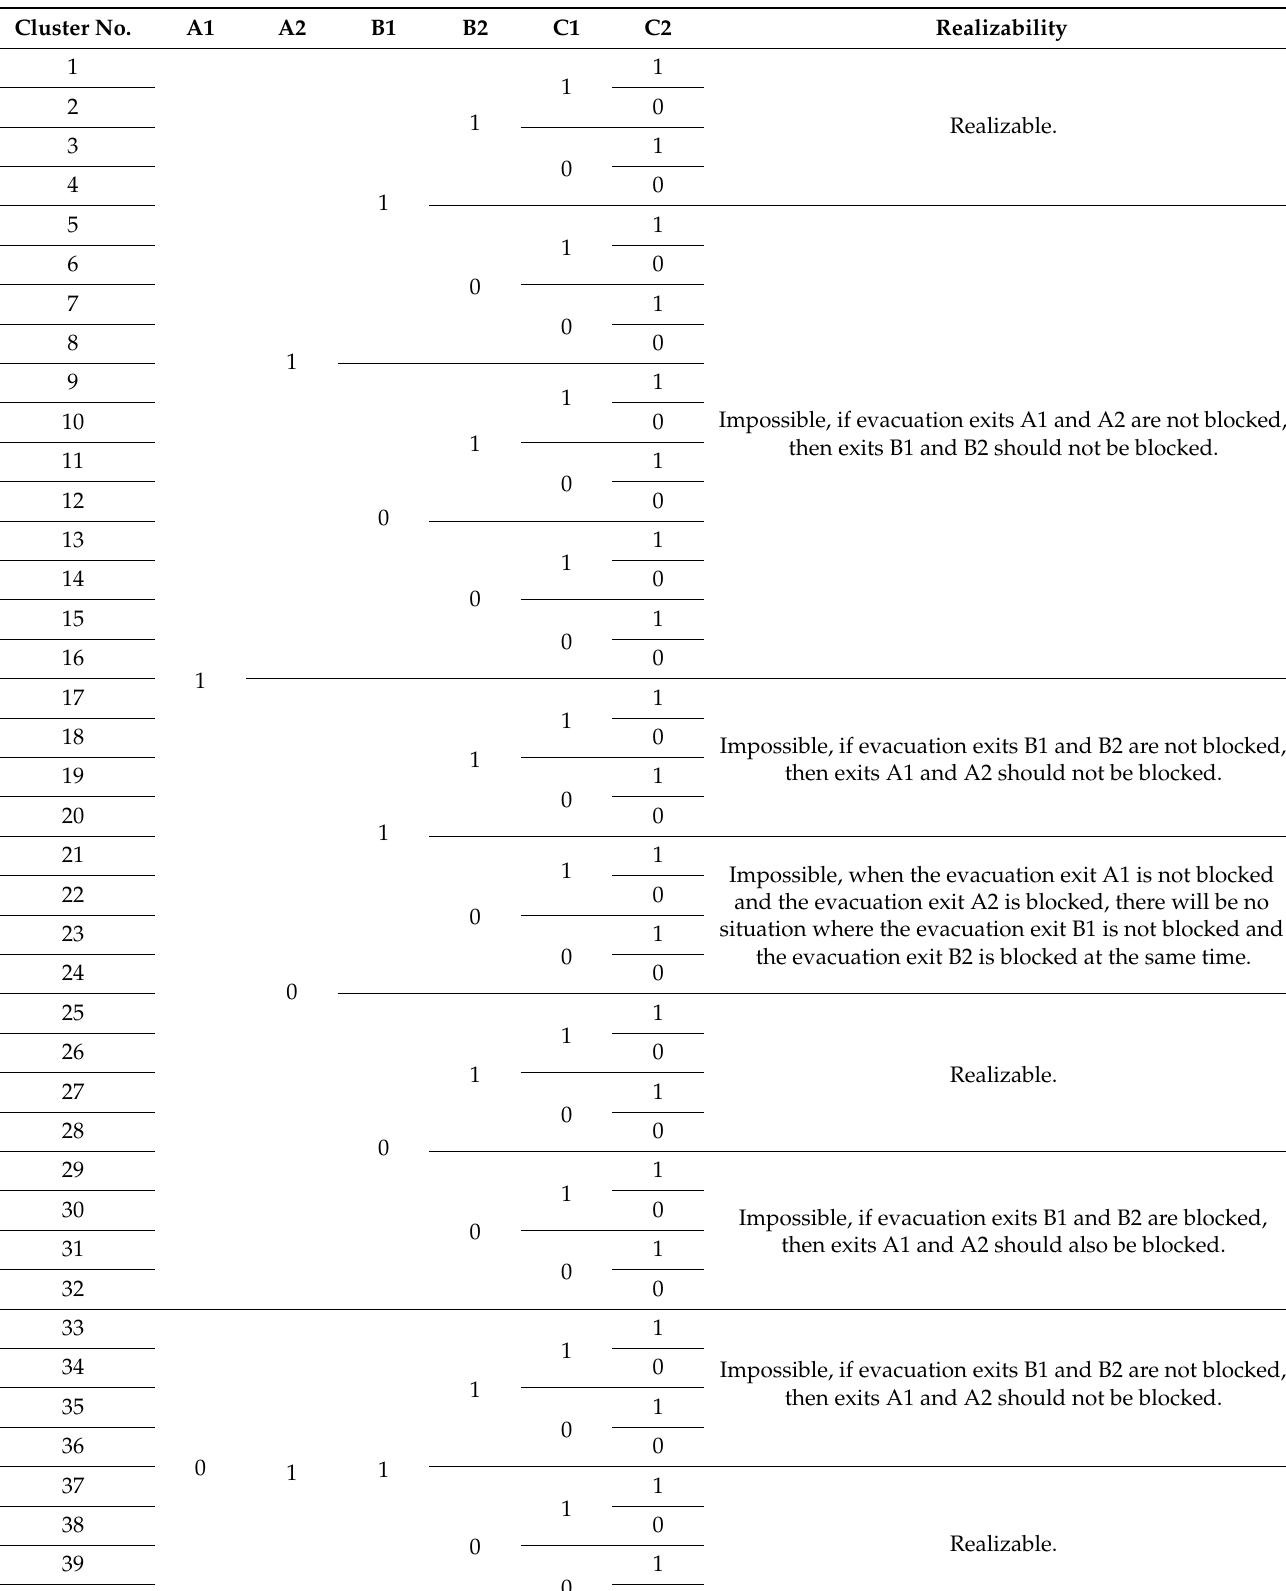
Table 2. All clusters of blockages of evacuation exits A1, A2, B1, B2, C1, and C2. Cluster